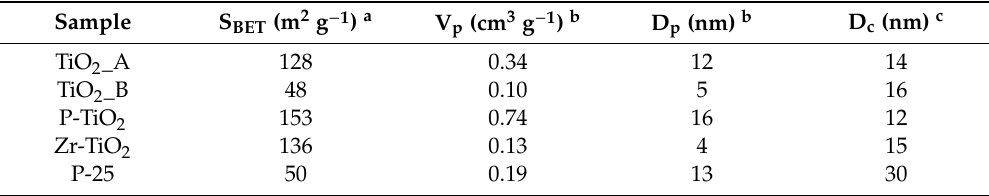
Table 1. Textural and structural properties of the prepared